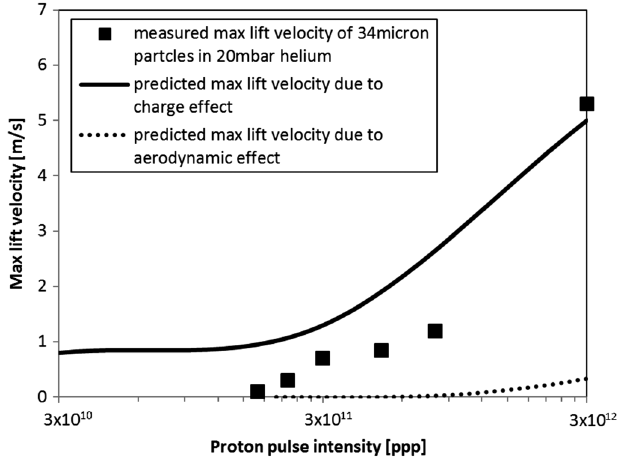
FIG. 21. Maximum lift velocity, comparing measurements with predictions from charge and aerodynamic models; helium pressure ¼ 20 mbar; mean particle diameter ¼ 34 μ